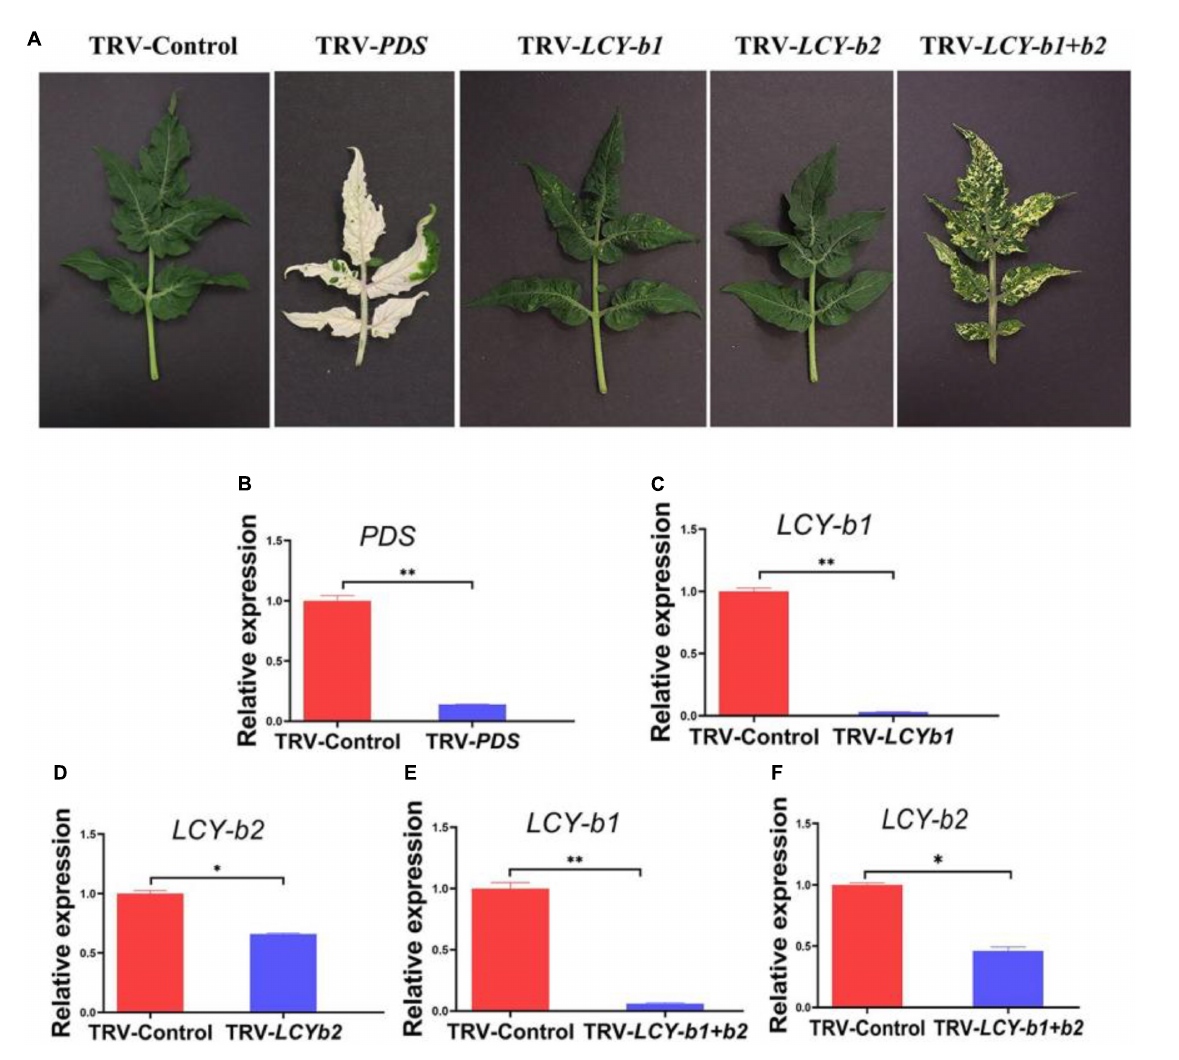
FIGURE5 VIGS analysis of LCY-bs. (A) The excised leaves of 6-week-old tomato plants infected separately with vectors containing no insert (TRV-Control), specific sequences (TRV- PDS ; TRV- SlLCY-b1; TRV- SlLCY-b2: TRV- SlLCY-b1 + b2) . (B) Analysis of relative gene expression for PDS gene of tomato leaves in TRV-Control and TRV- PDS groups. (C) Analysis of relative gene expression for LCY-b1 gene in tomato leaves in TRV-Control and TRV- LCY-b1 groups. (D) Analysis of relative gene expression for LCY-b2 gene in tomato leaves in TRV-Control and TRV- LCY-b2 groups. (E) Analysis of relative gene expression for LCY-b1 gene in tomato leaves in TRV-Control and TRV- LCY-b1 + b2 groups. (F) Analysis of relative gene expression for LCY-b2 gene in tomato leaves in TRV-Control and TRV- LCY-b1 + b2 groups. The internal reference was actin gene. The values were expressed as the mean ± SD of three independent repeats. ∗ Indicated a P -value < 0.05; ∗∗ Indicated a P -value < 0.01 ( t-